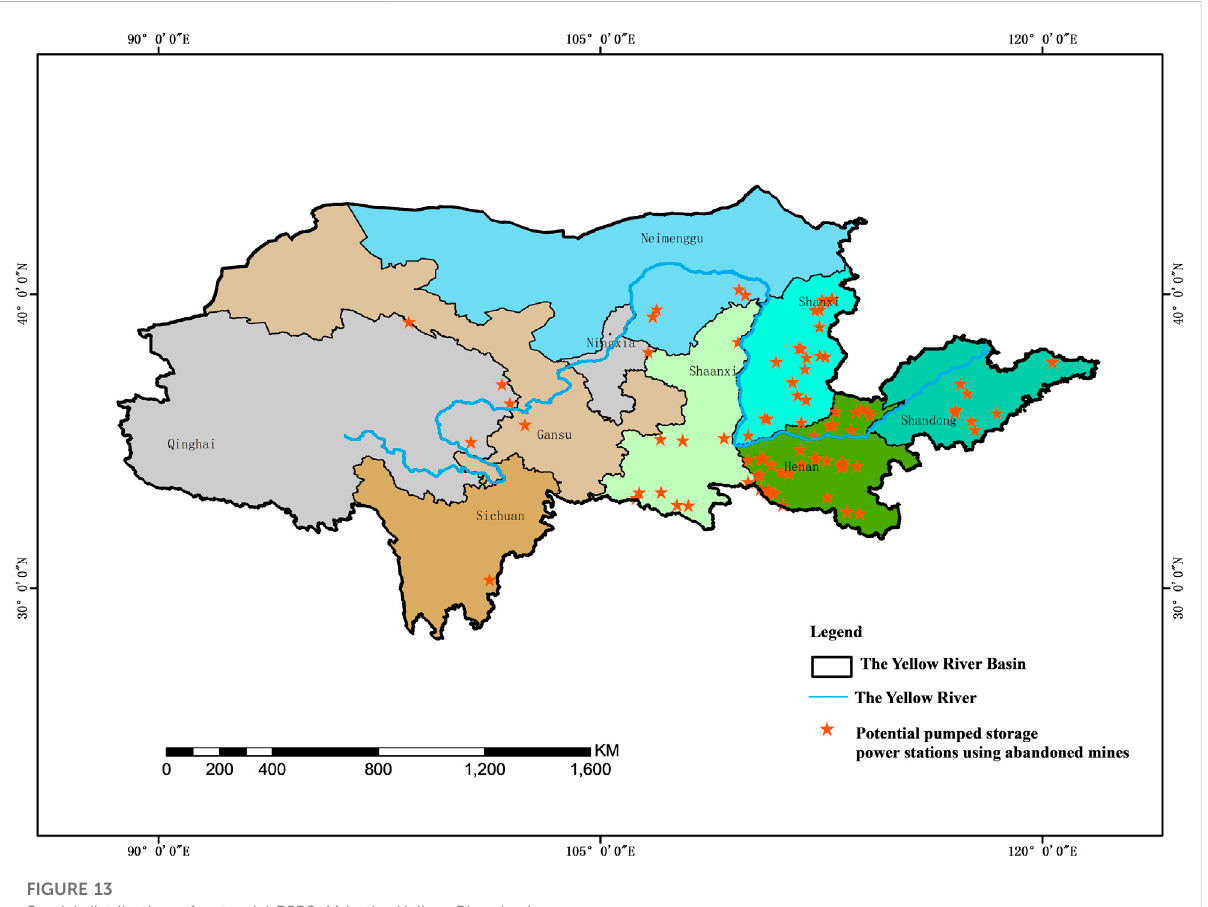
FIGURE 13 Spatial distribution of potential PSPSuM in the Yellow River basin.